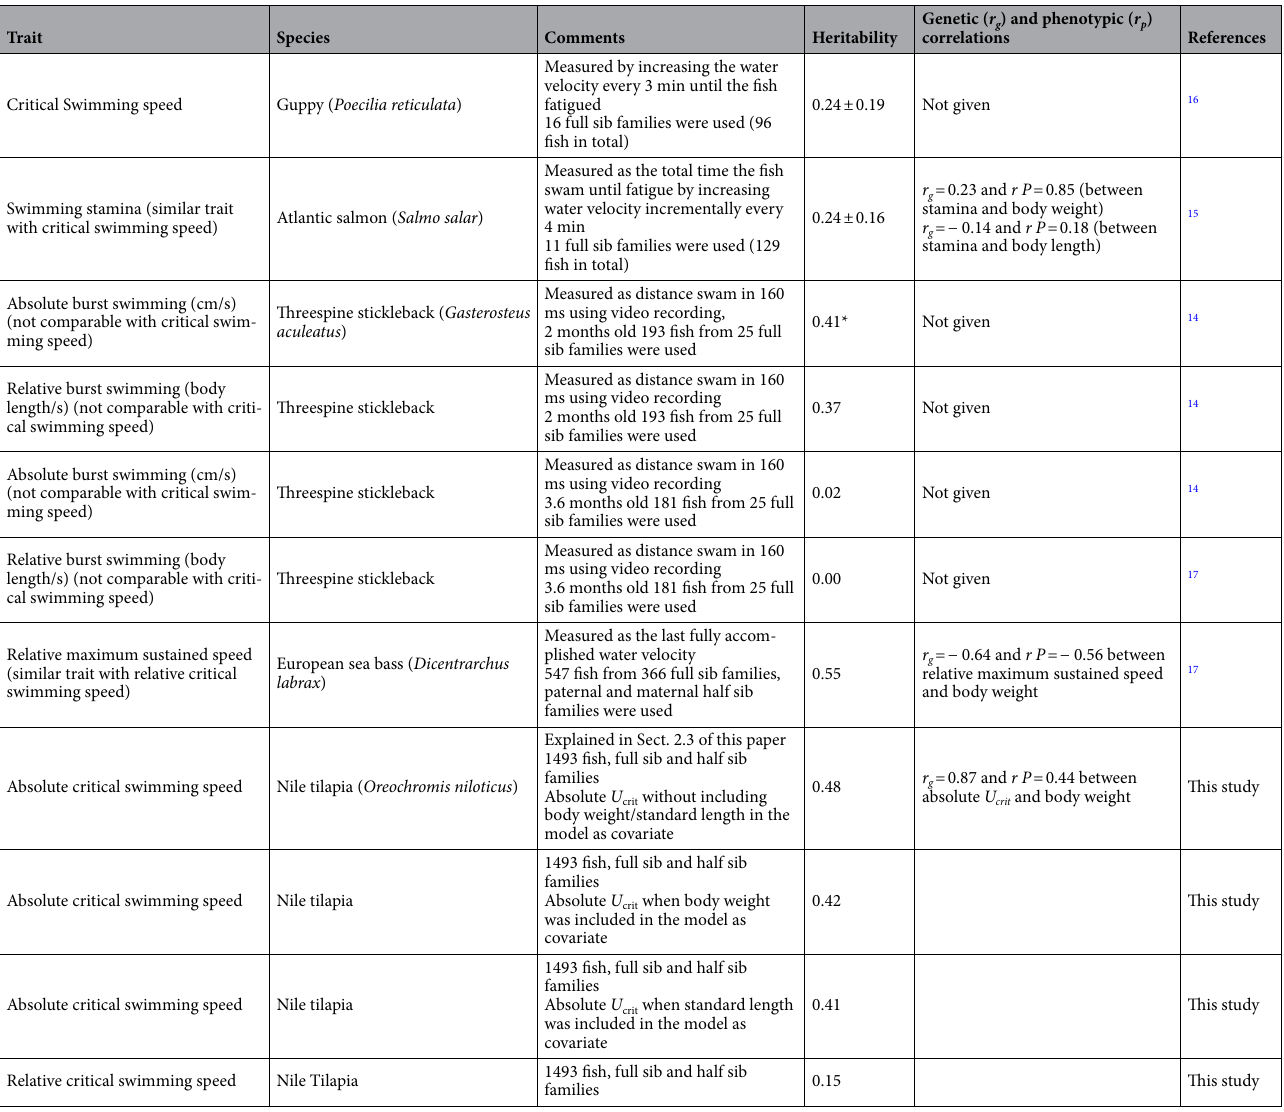
Table 4. Summary of the studies that estimated heritability for different swimming performance traits, genetic phenotypic correlation between swimming performance and body weight, and between swimming performance and body